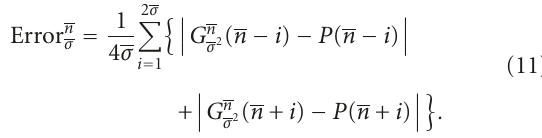
algorithm is run solely for the obtained candidate points, the total number of computation is certainly less than the product of Σ and Z .